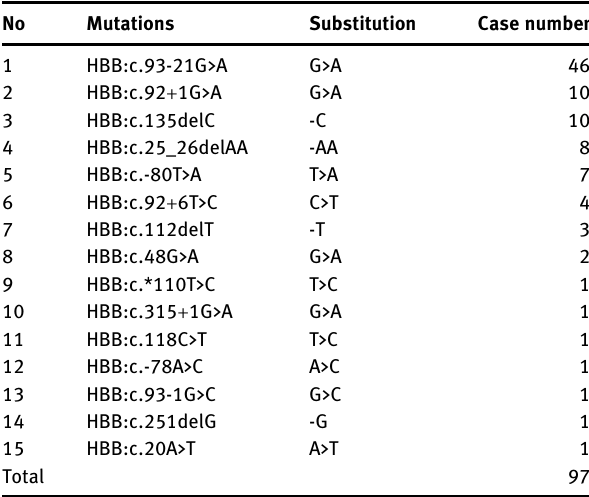
Table  : β -thalassemia homozygous patients in the